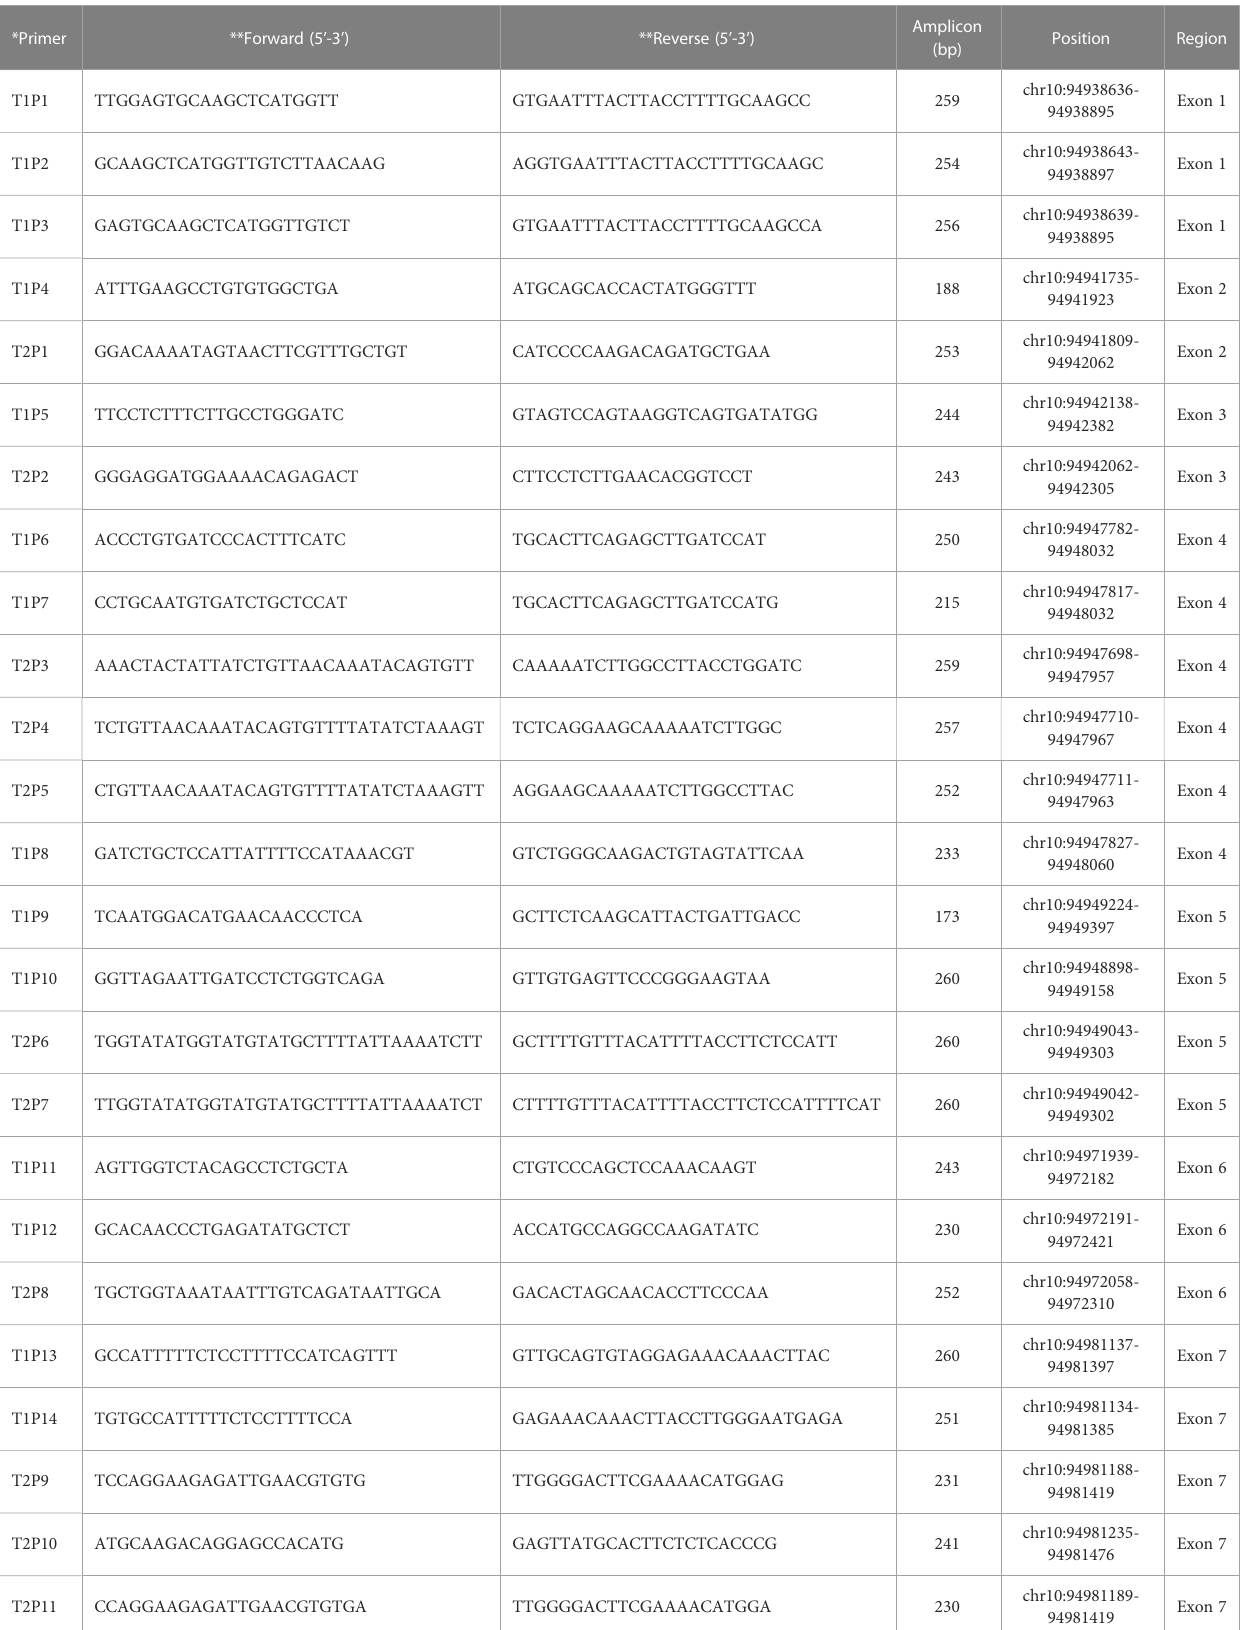
TABLE 1 Primers used for the fi rst round of multiplex PCR